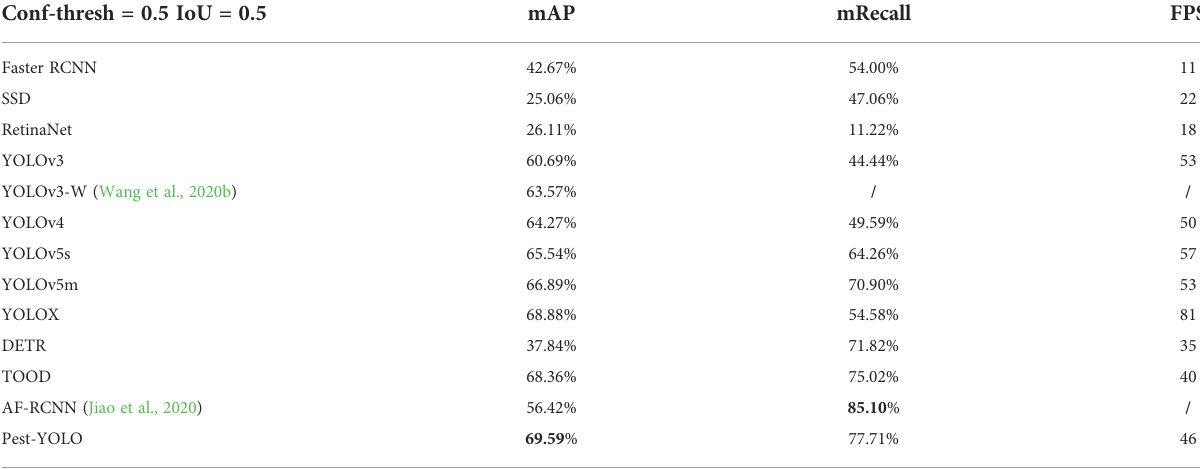
TABLE 6 Comparison results of the proposed model and several state-of-the-art detectors. Conf-thresh = 0.5 IoU =